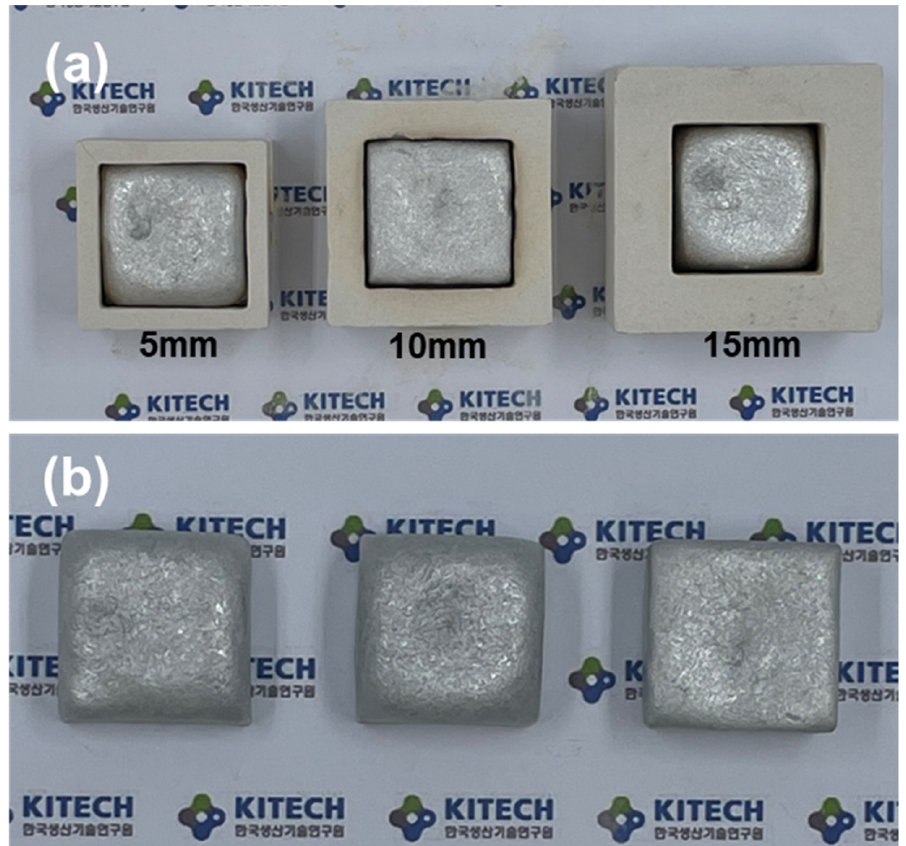
Figure 7. ( a ) The molten metal was poured into the mold and the casting and ( b ) specimens after casting aluminum with box mold thicknesses of 5, 10, and 15 mm.